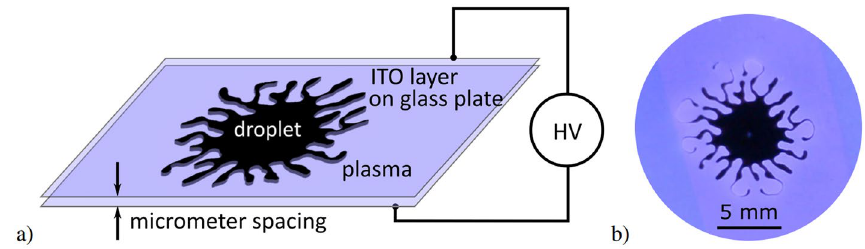
Figure 1. ( a ) The simplified schematic of the experimental setup for plasma generation in Hele-Shaw cell containing the viscous droplet and ( b ) the photograph of the viscous liquid fingering pattern (dark) induced by the surrounding plasma